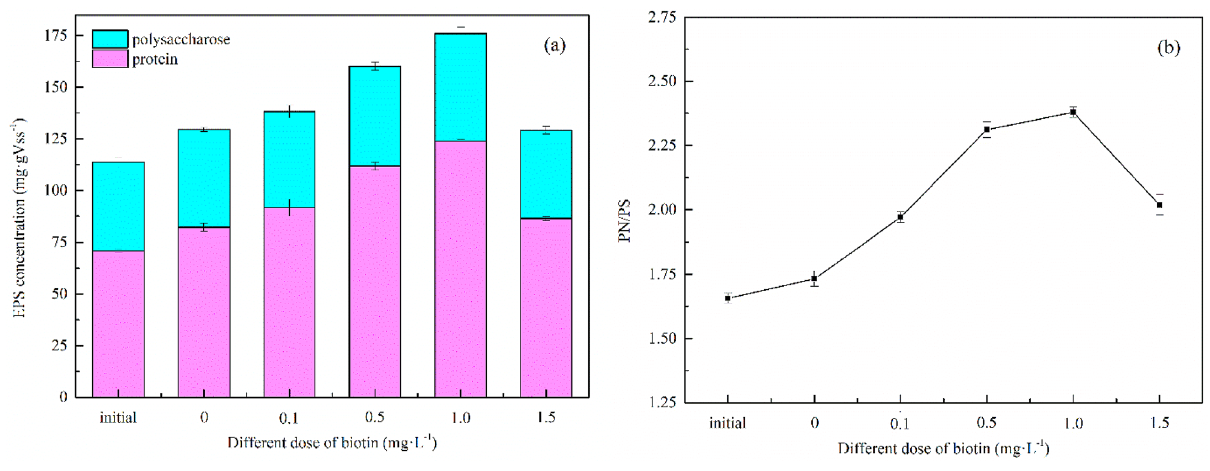
Figure 3. Changes of EPS concentrations ( a ) and PN/PS ratio ( b